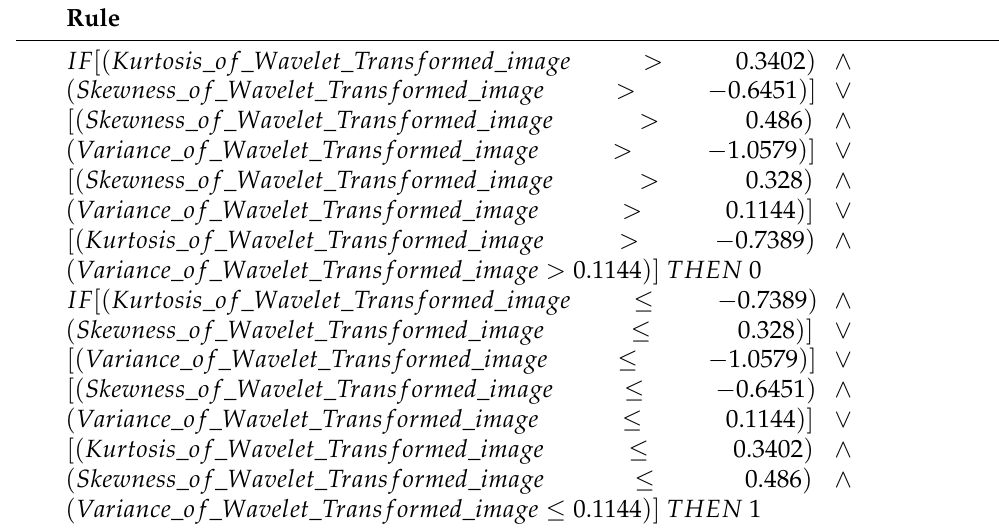
Table A11. Final rule set, for the banknote authentication dataset generated by DEXiRE.